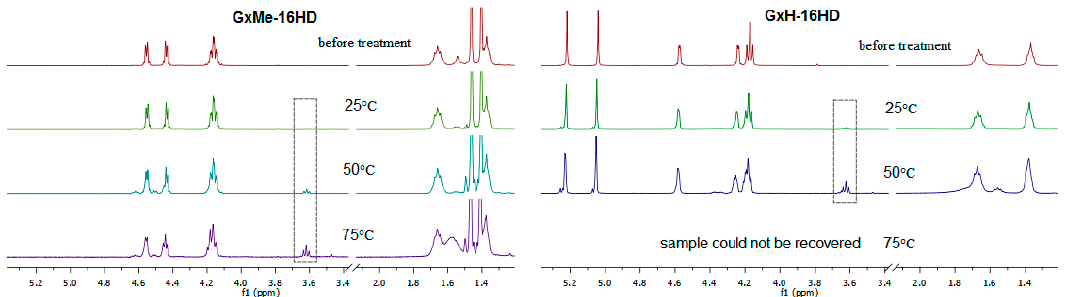
Figure 10. 1H NMR overlay spectra of GxMe-16HD and GxH-16HD samples before and after hydrolytic treatment in citric acid 5% solution for 30 days at 25, 50, and 75 °C.